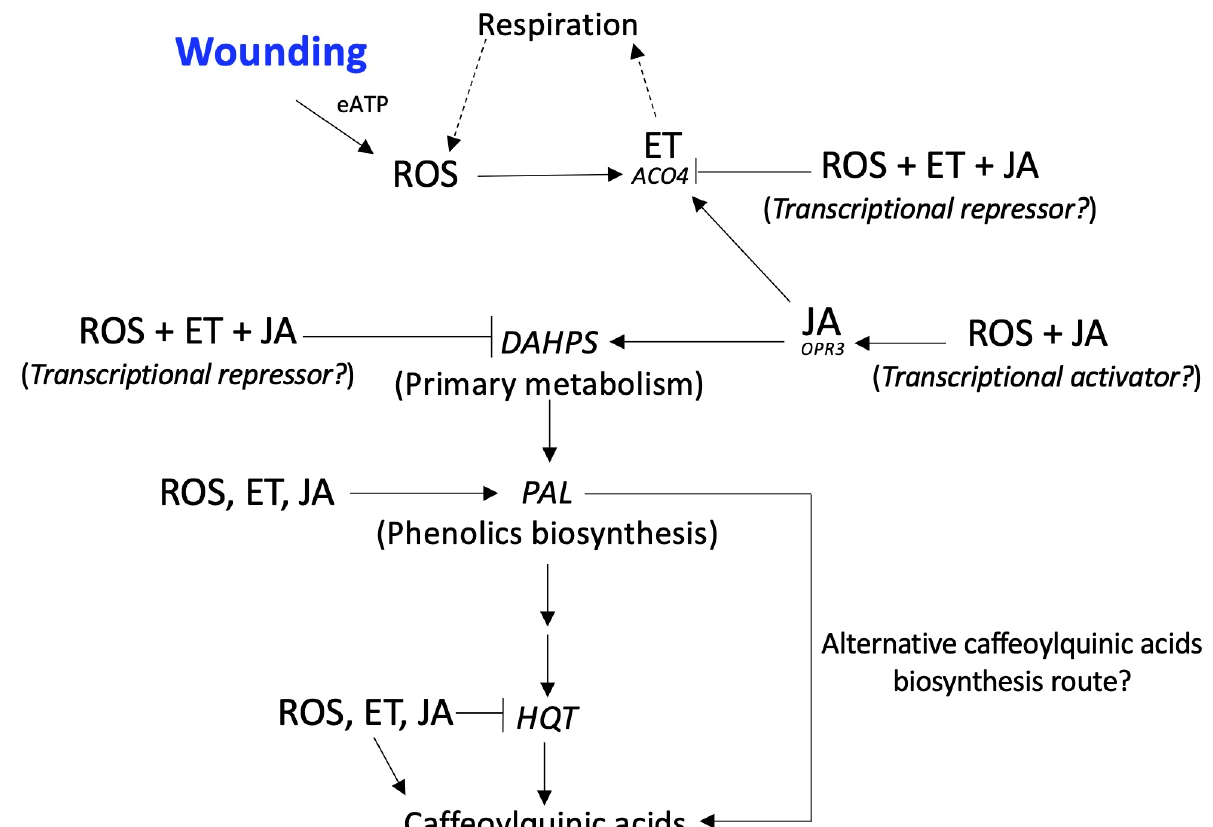
Figure 4. Proposed model explaining the cross-talk and physiological role of reactive oxygen species (ROS), ethylene (ET), and jasmonic acid (JA) in wound-induced phenolic biosynthesis in broccoli. After wounding, extracellular ATP (eATP) was released from the plant cell’s cytoplasm and served as the primary signal of the wound response, triggering ROS production. JA and ROS alone induced ET biosynthesis, whereas we saw the highest expression of the ACO4 gene when the three signaling molecules were blocked. ROS and JA induced the biosynthesis of JA through the activation of OPR3 . JA played a major role in the wound-induced activation of DAHPS , whereas inhibiting the three signaling molecules increased the expression of the gene, suggesting that the three signaling molecules activated a transcriptional repressor. The three signaling molecules played an important role in the activation of PAL . The main phenolic compounds accumulated due to wounding were the caffeoylquinic acids. None of the signaling molecules played a role in the activation of HQT , which coded for an enzyme involved in caffeoylquinic acid biosynthesis, suggesting an alternative caffeoylquinic acid biosynthesis route activated by wounding in broccoli.